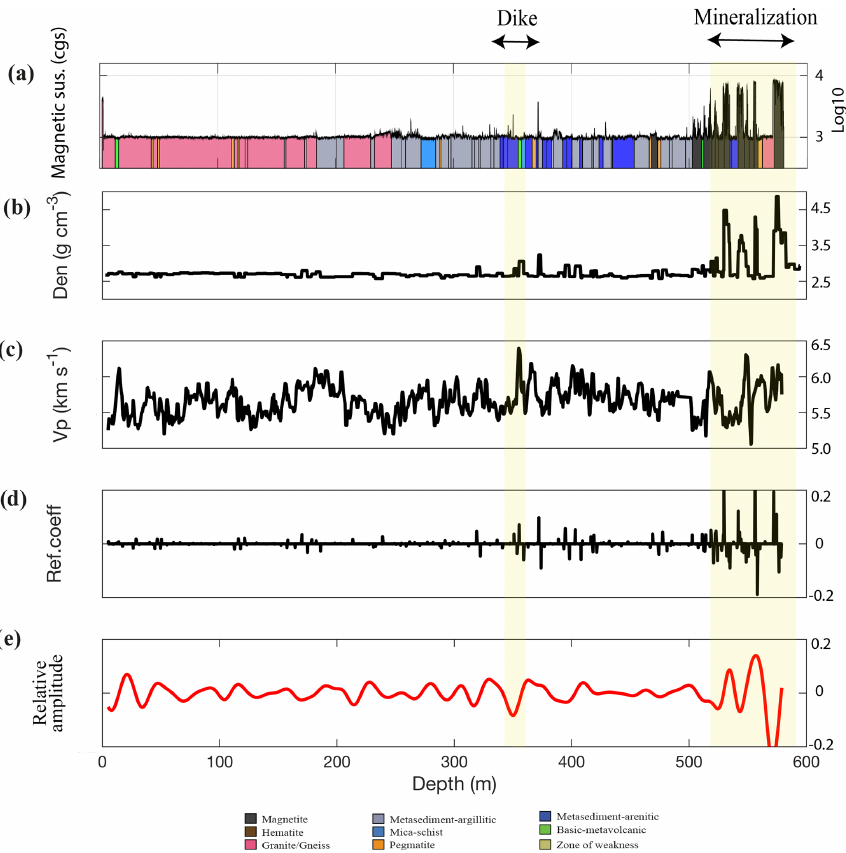
Figure 8. Logging data from BB14004. (a) Natural gamma and rock types, (b) density, (c) P wave velocity values, and (d) calculated reflection coefficients. (e) The synthetic trace using a 70Hz Ricker wavelet. The iron oxide deposits (530–570m) produced a strong seismic signal in the synthetic trace.